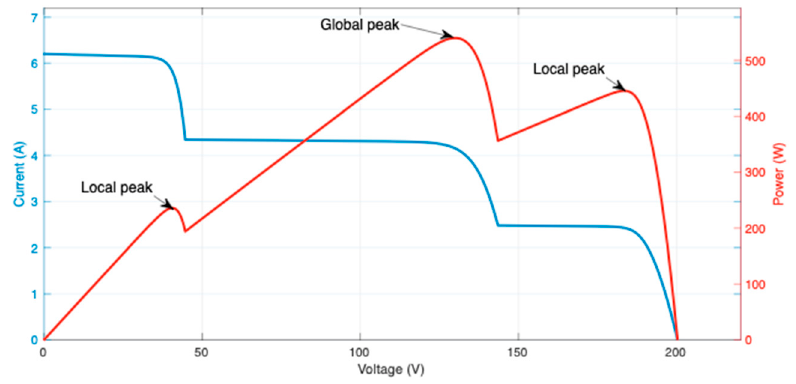
Figure 1. Typical curve of a shaded PV panel.